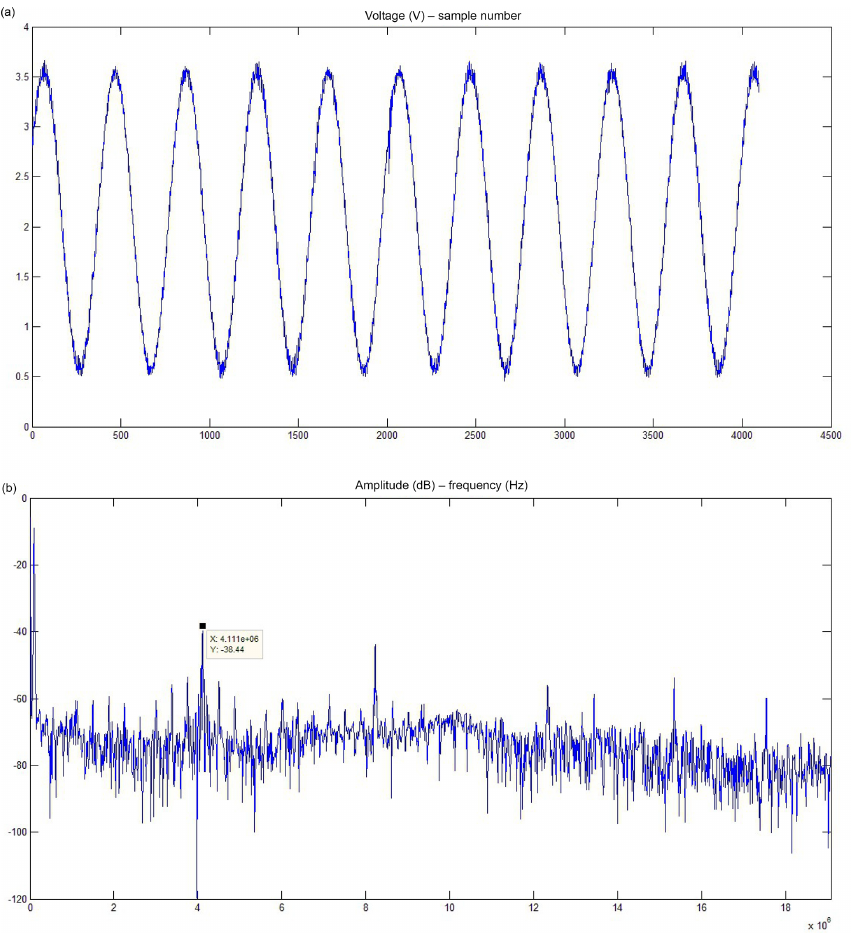
Figure 11. Test results of the high-speed current acquisition channel. (a) Time domain waveform of the 150mVpp, 100KHz sinusoid acquired by the high-speed current recording device at a 50A level. (b) Amplitude-frequency characteristics of the 4906 samples subjected to FFT (Hanning window